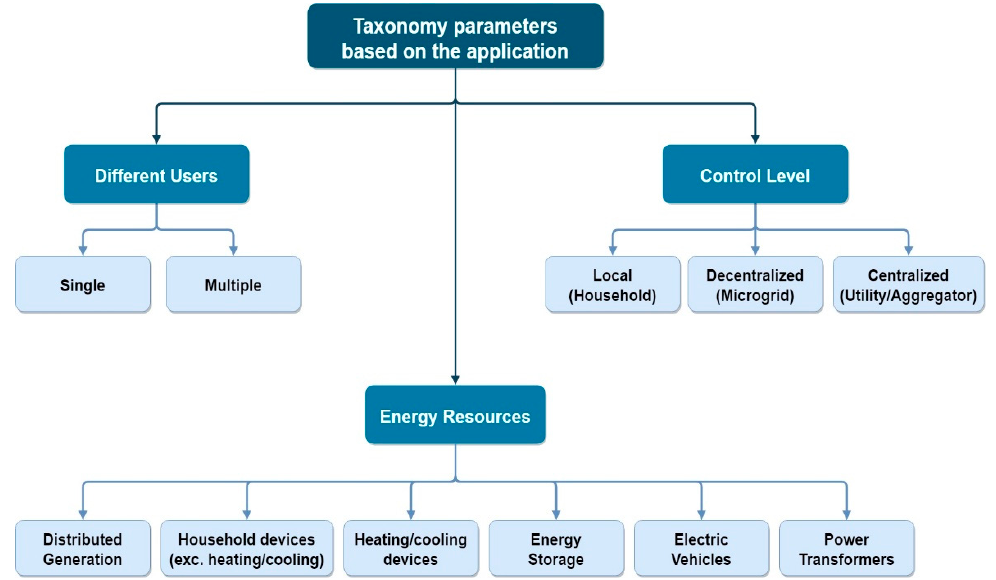
Figure 2. Taxonomy parameters based on the application.